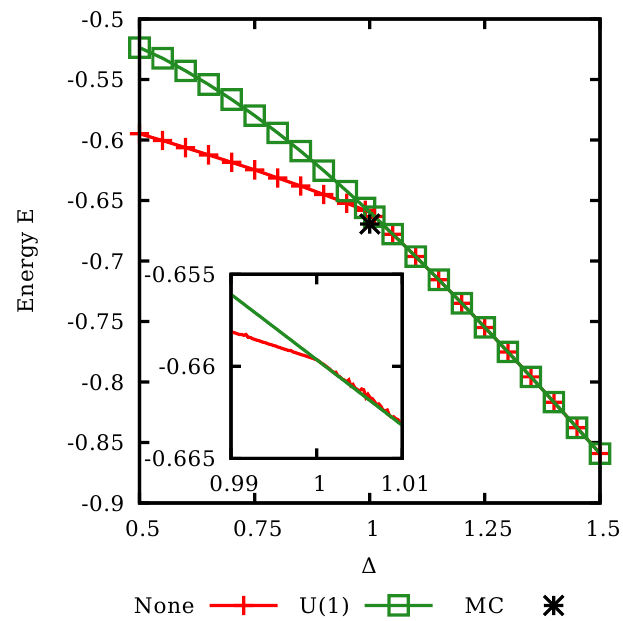
Figure 6: Obtainable ground-state energies in the anisotropic Heisenberg model at D = 2 with and without U ( 1 ) symmetry. Inset: Zoom into the central region, ∆ values are placed 0.0025 apart. Lines are guides to the eye. The results start to differ at ∆ < 1.